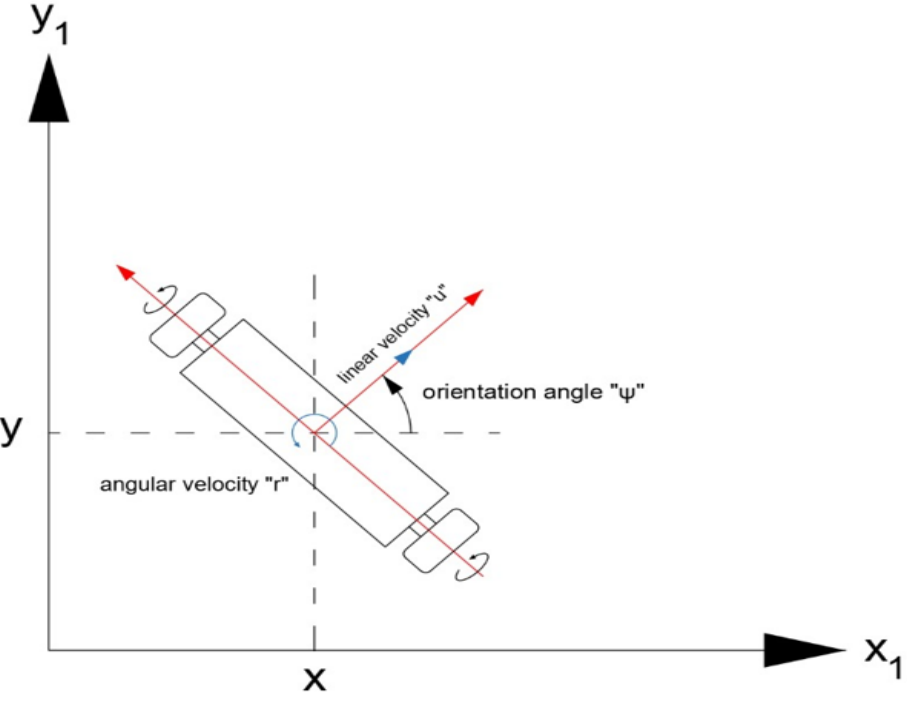
Figure 1. Dynamics of TWR on a planar surface and velocity diagram. The TWR’s motion changes with respect to time, so its position coordinates (both x and y) and orientation angle Ψ are represented by Equation (1) given below.